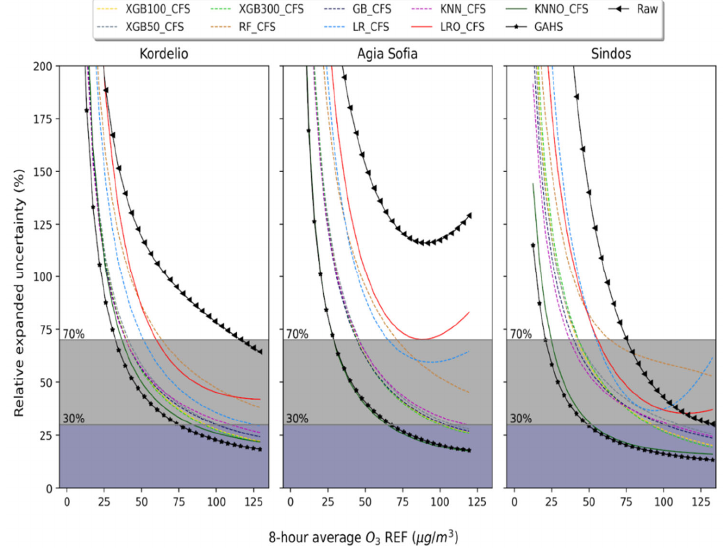
Figure 5. Model and sensor comparison against reference measurements in terms of REU for the ideal scenario. GAHS clearly outperforms all other approaches for ozone except Agia Sofia where GAHS and KNNO show identical curves that correspond to an exponential fit .